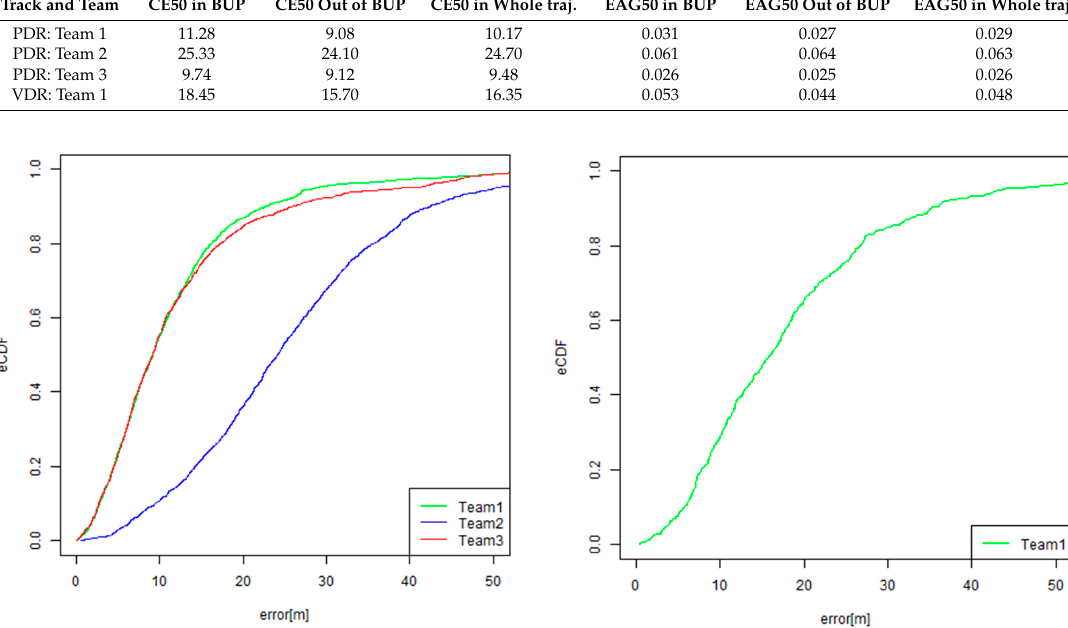
Figure 16. Results of the eCDF of the C.E. (circular error) ( Left : PDR track, Right : VDR track).